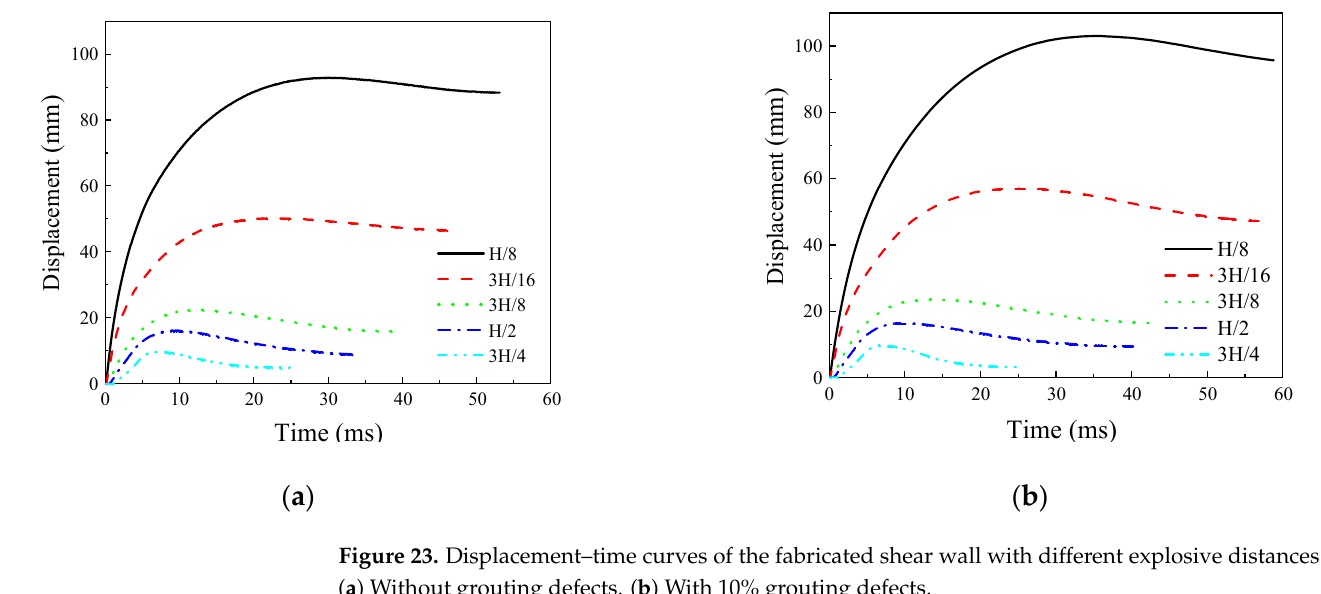
Figure 22. Peak displacement of the shear wall under different TNT equivalents. When the TNT equivalent is 10 kg, the dynamic responses of five fabricated shear walls, with distances from the initiation point to the blasting surface of the shear wall 1/8, 3/16, 3/8, 1/2, and 3/4 that of the height of the prefabricated shear wall, are studied. That is, the distances from the initiation point to the blasting surface are 343.75 mm, 515.62 mm, 1031.25 mm, 1375 mm, and 2062.5 mm, respectively. Considering that the damage distributions of the front blasting surface and back blasting surfaces are similar, only the displacement–time curves of the fabricated shear wall corresponding to different distances of the front blasting surface are given here, as shown in Figure 23a. The limit displacement of the fabricated shear wall decreases with the increase in the distance to the blasting surface, and the peak displacements are 92.83 mm, 50.06 mm, 22.36 mm, 16.07 mm, and 9.56 mm, respectively.